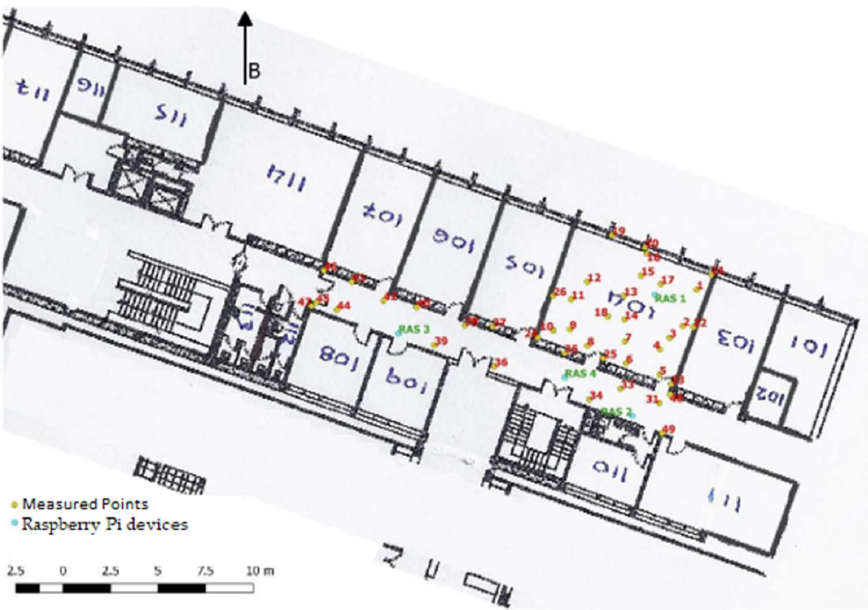
Figure 7. The position of the measured points (in yellow) and the Raspberry Pi devices (in cyan).